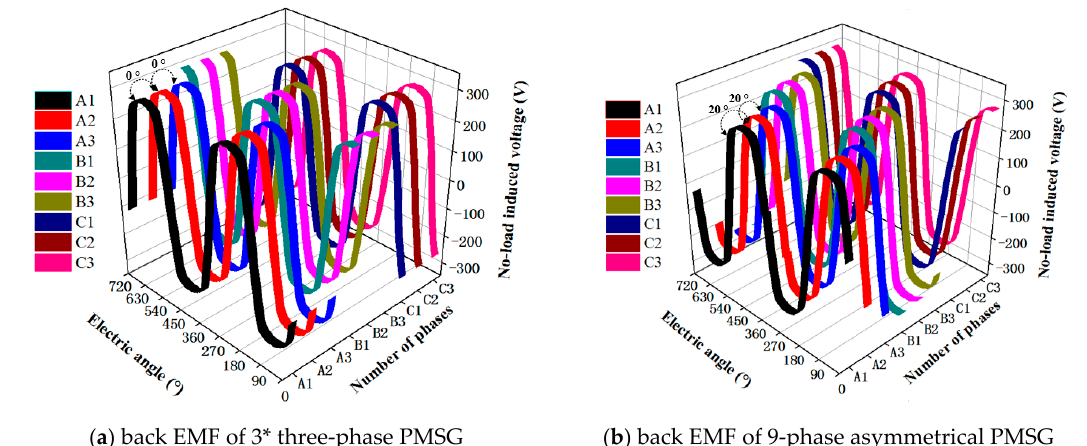
Figure 4. No-load back EMF of 3 *three-phase and asymmetric 9-phase PMSG.